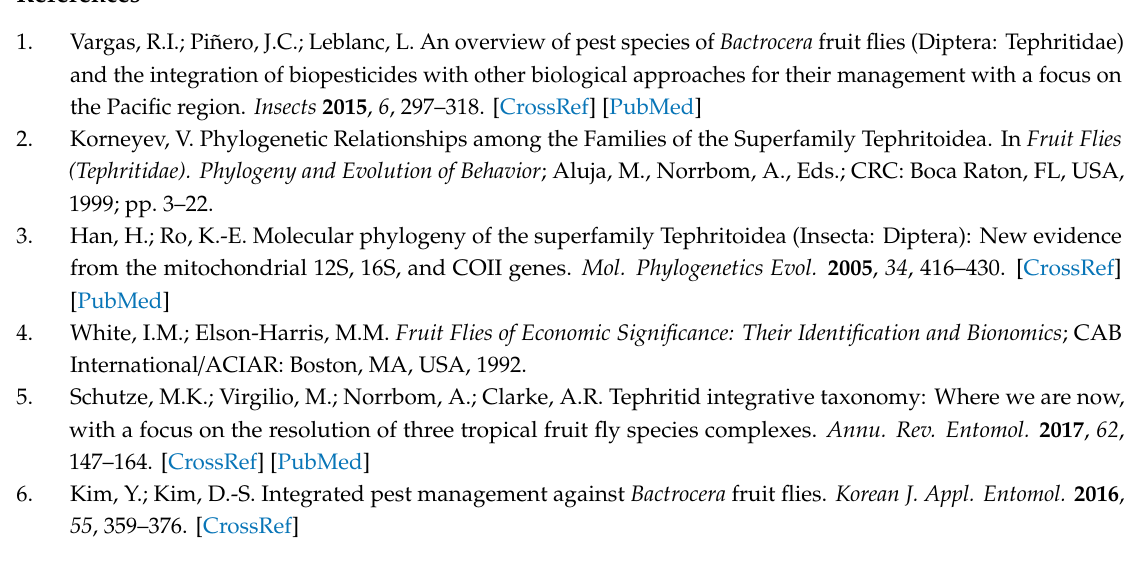
Figure S1, Sexual morphs of Z. scutellata adults. Table S1, Primers used in this study for